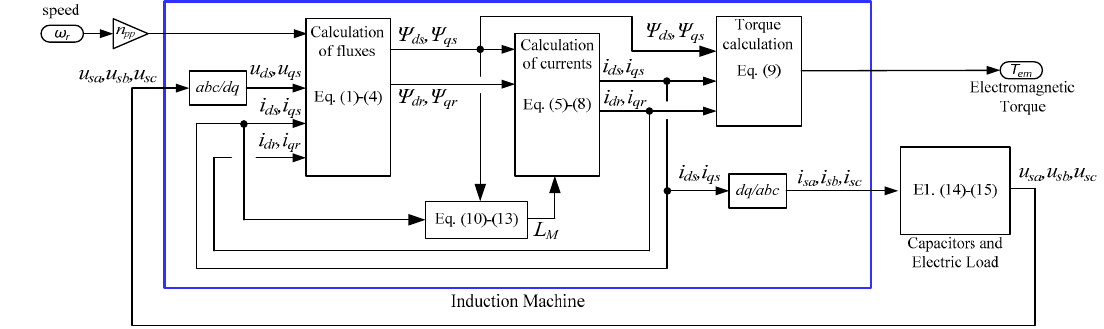
Figure 2. SEIG model block diagram.